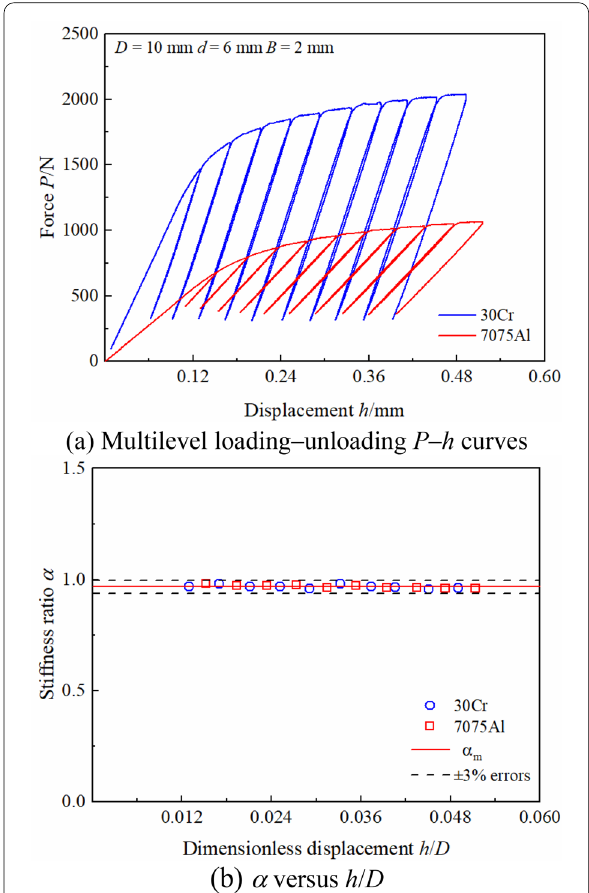
Figure 8 Multilevel loading–unloading tests to determine